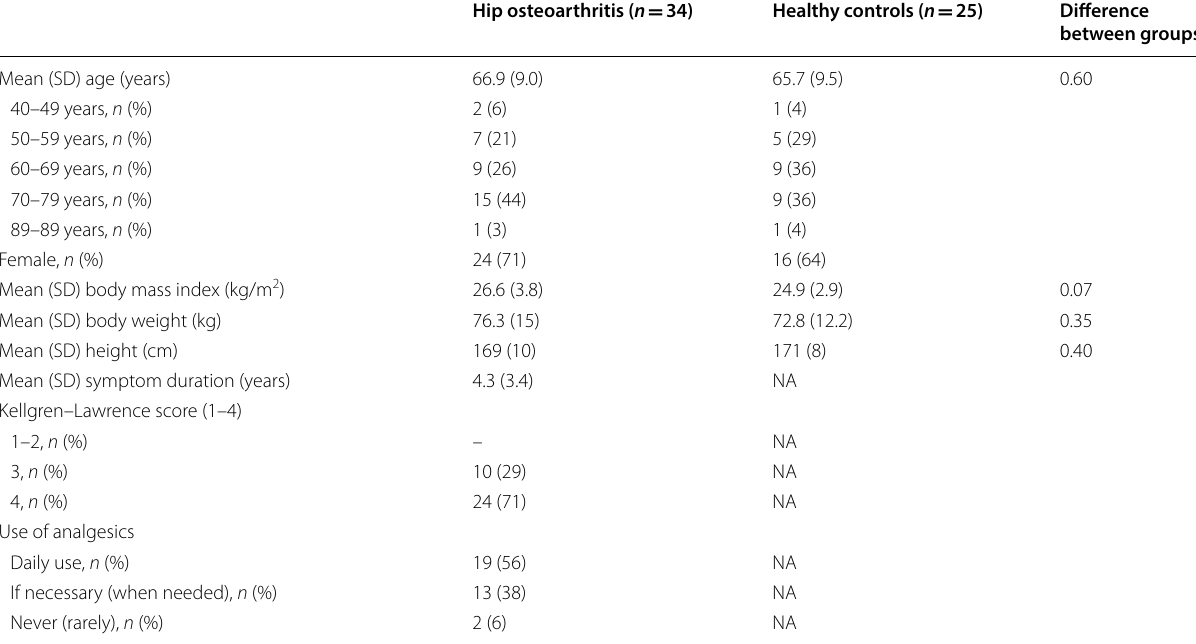
Table 1 Baseline characteristics of patients with hip osteoarthritis and healthy controls included in the